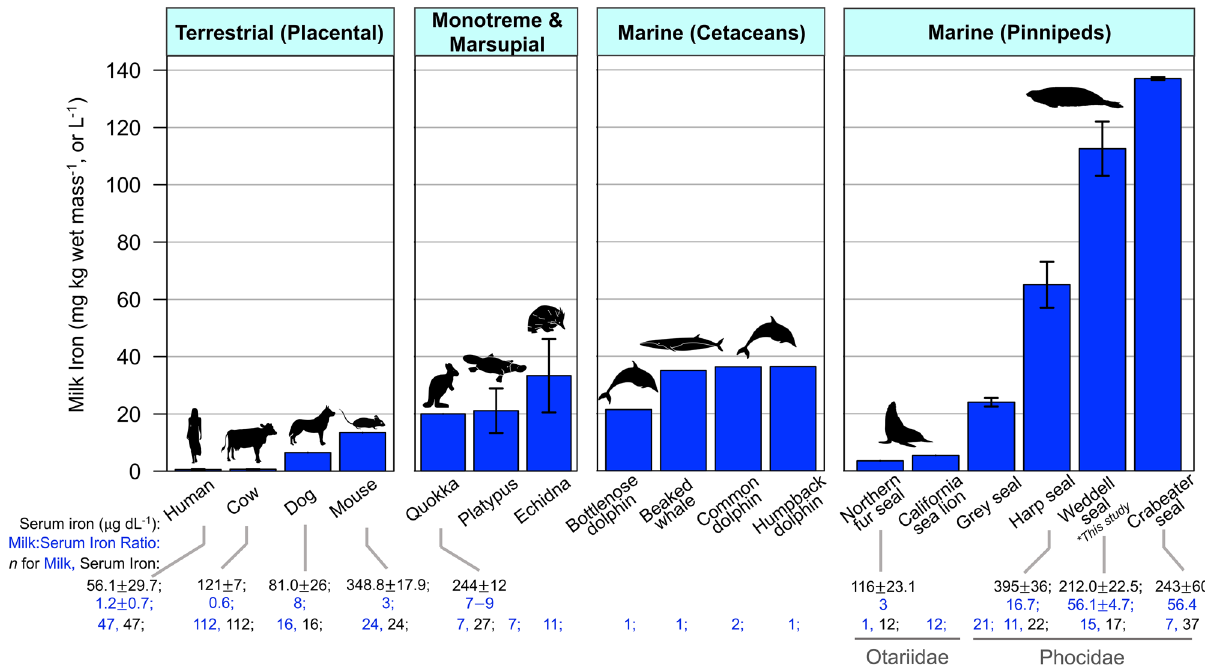
Fig. 7 Milk iron concentrations (mean ± SE) across a range of terrestrial and marine mammals. ( Below; black text ) Mean ± SE serum iron concentrations are shown, and ( blue text ) the milk:serum iron ratio indicates the magnitude that each species prioritizes iron mobilization into the milk to transfer to offspring. Data are from sources: Human ( Homo sapiens , milk iron at 2 nd week lactation: 0.55 ± 0.20 mg L − 1 ; 4 th month lactation: 0.38 ± 0.18) 46 , Cow (